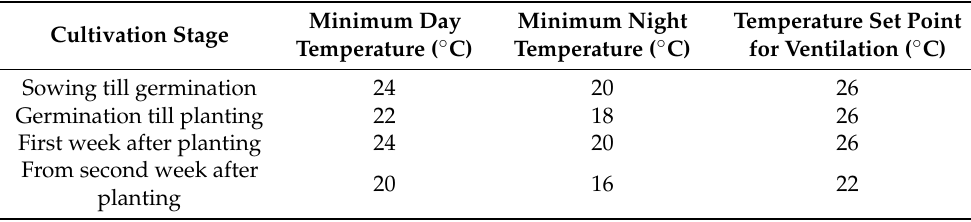
Table 1. Temperature regime throughout the cultivation